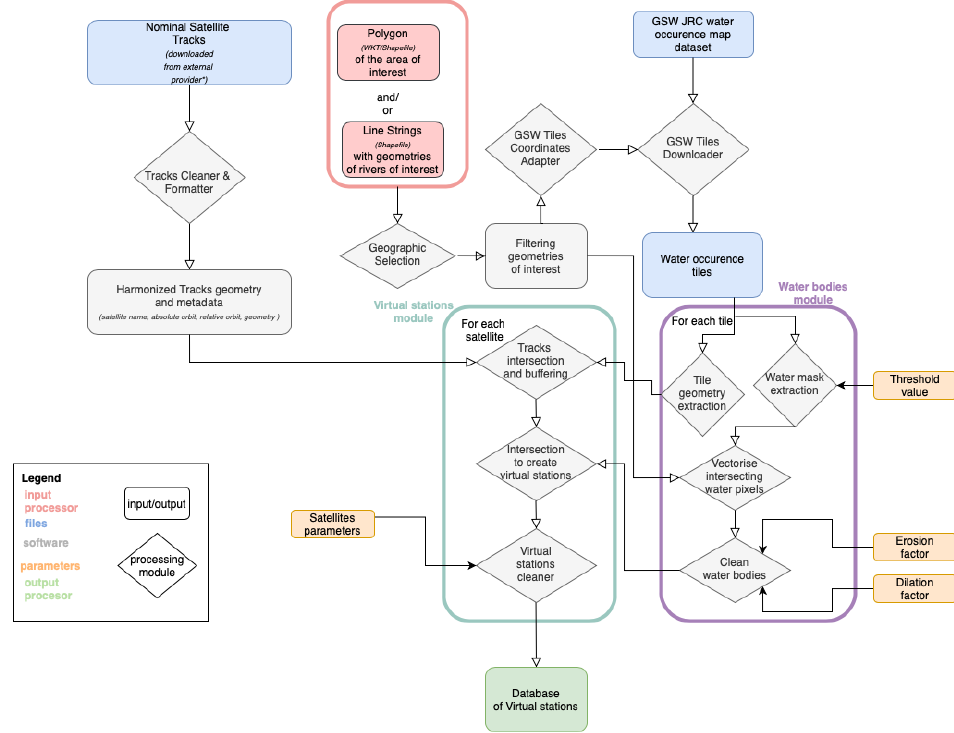
Figure 2. Virtual stations extractor ( teroVIR )